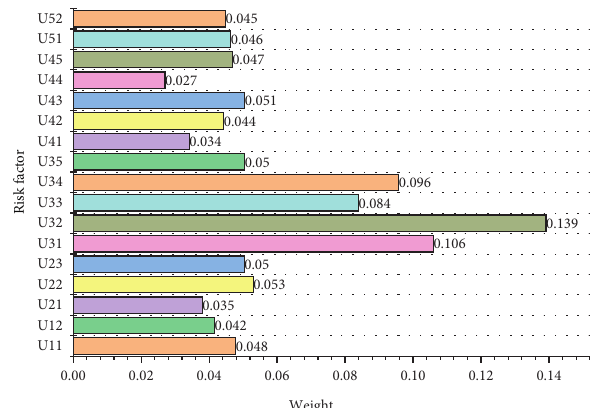
Figure 7: Subjective